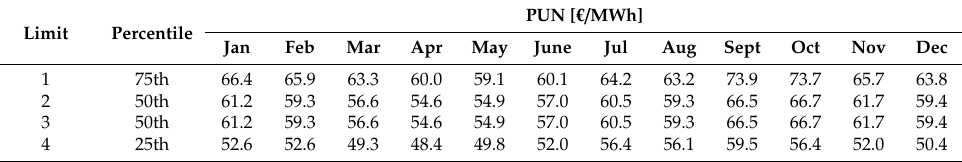
Table A2. PUN Index thresholds limit for calculations over the